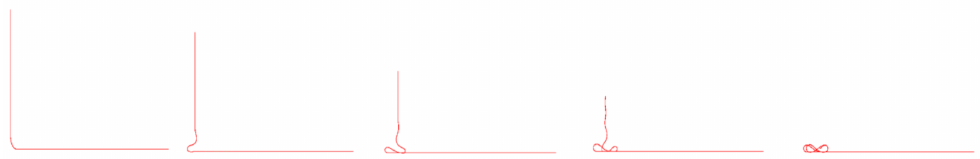
Figure 3. Configuration of a cable with the fast static equilibrium calculation method.